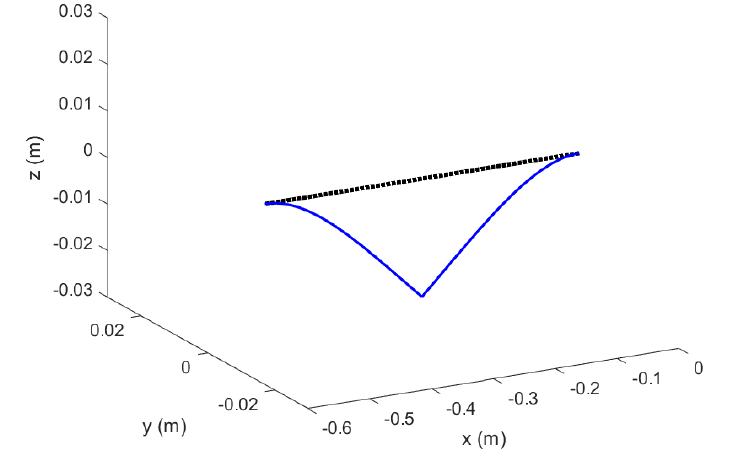
Figure 6. Mode 1 (out–of–plane/flapping) of two Euler–Bernoulli Beams connected through hinged joint.